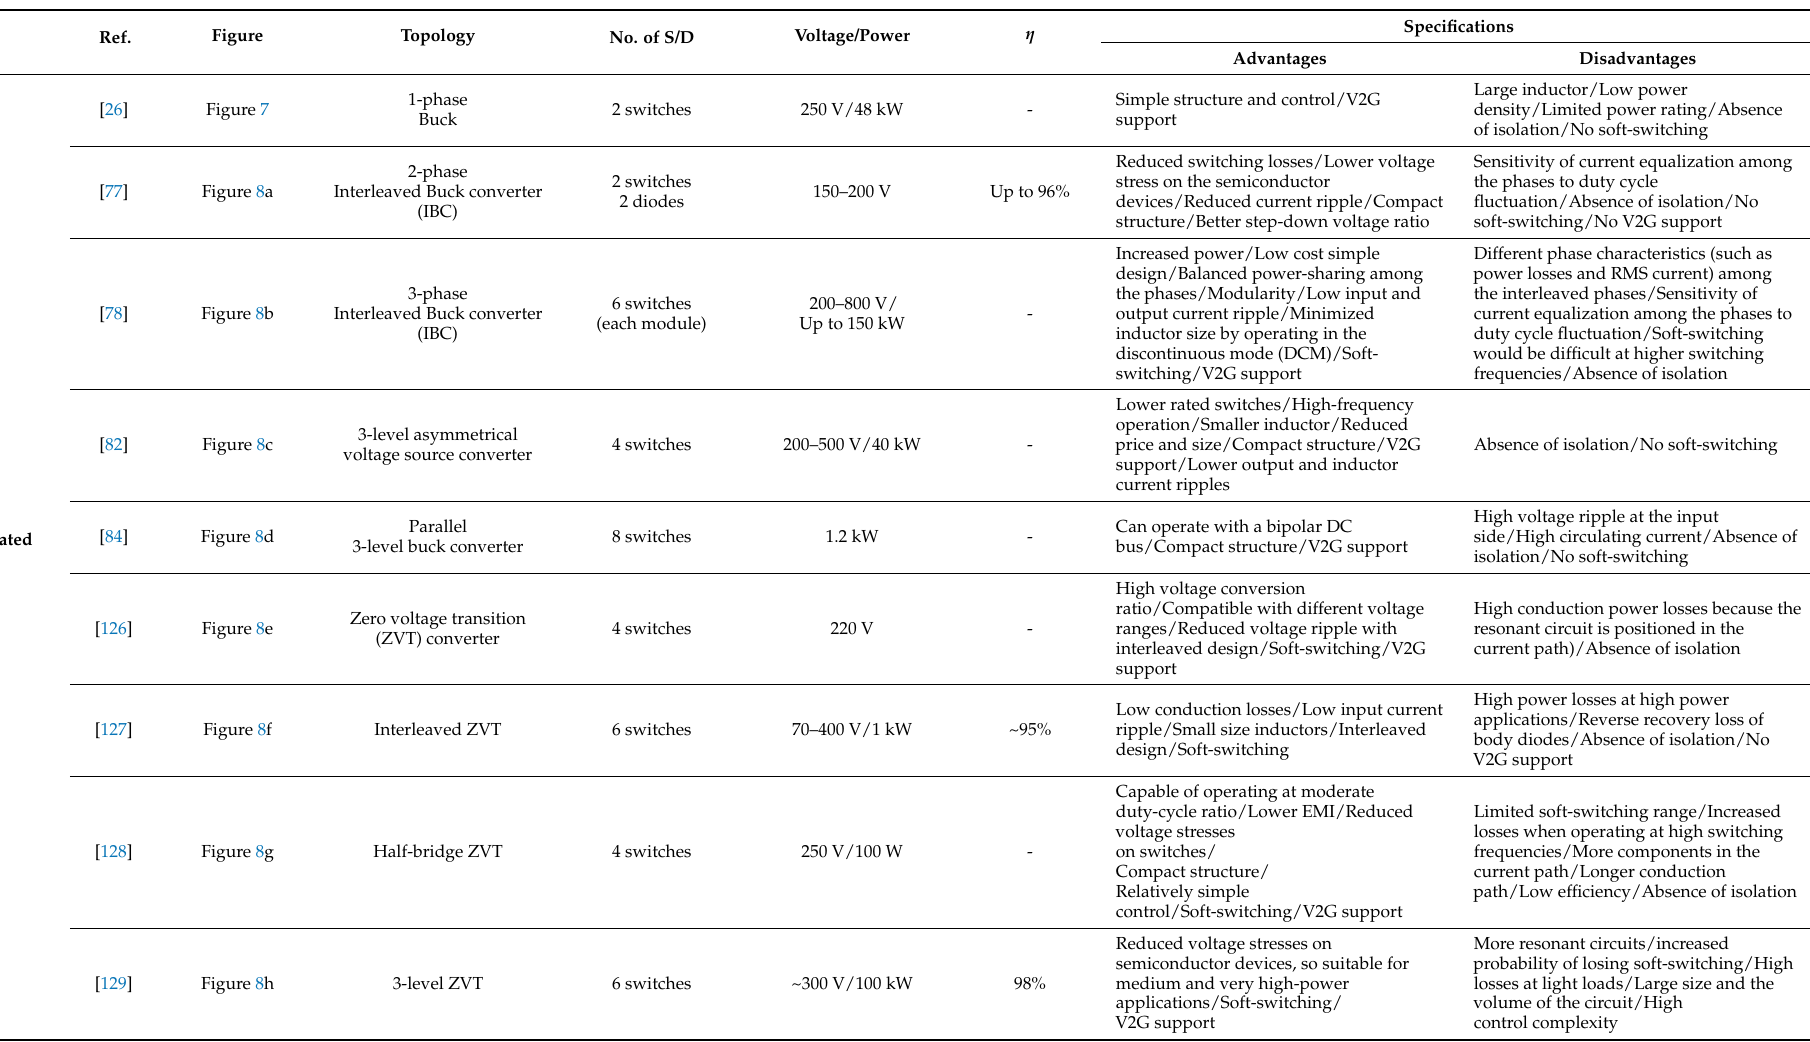
Table 3. Non-isolated and isolated DC–DC EV-interfaced